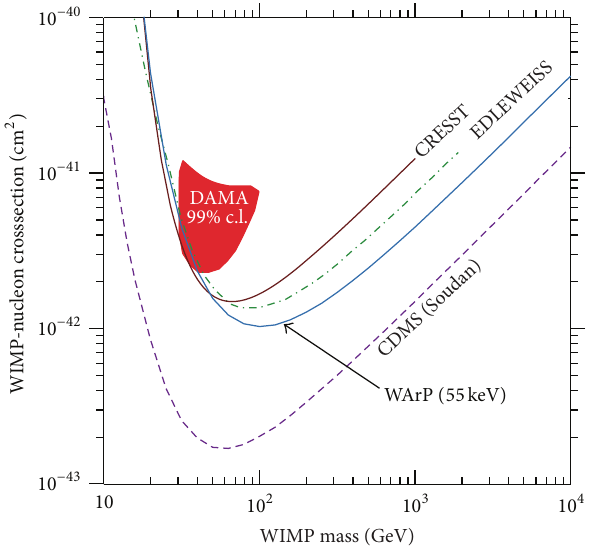
Figure 4: 90% C.L. spin-independent limit for WArP-2.3 l (solid blue line), compared with previous limits [28] available at the